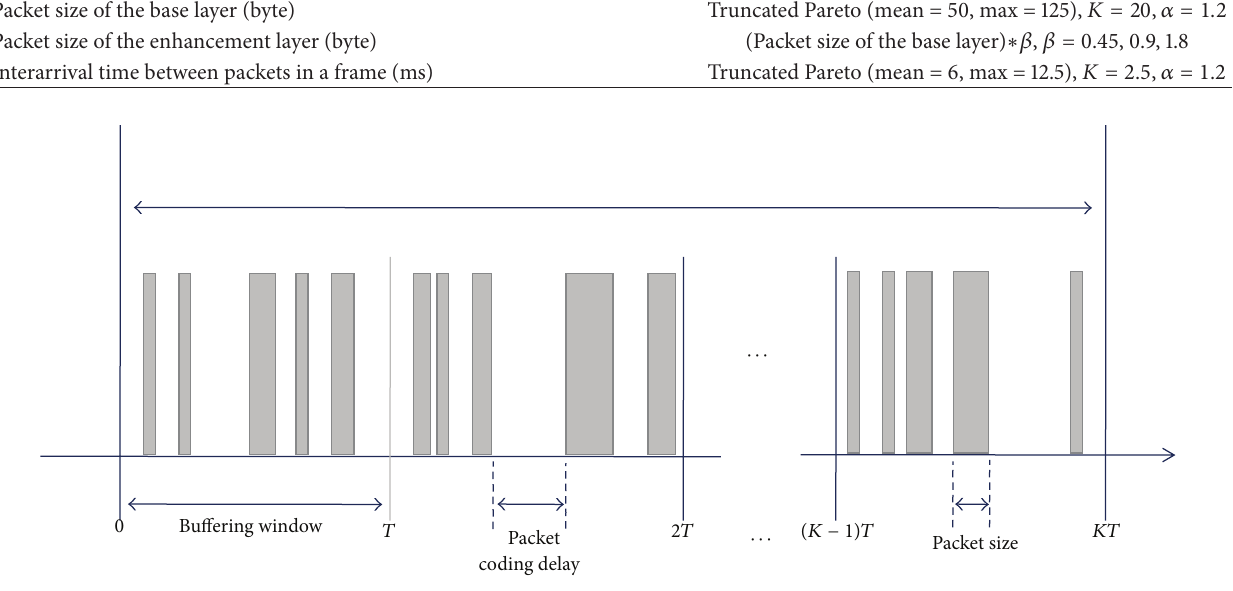
Figure 3: 3D A/V traffic model.